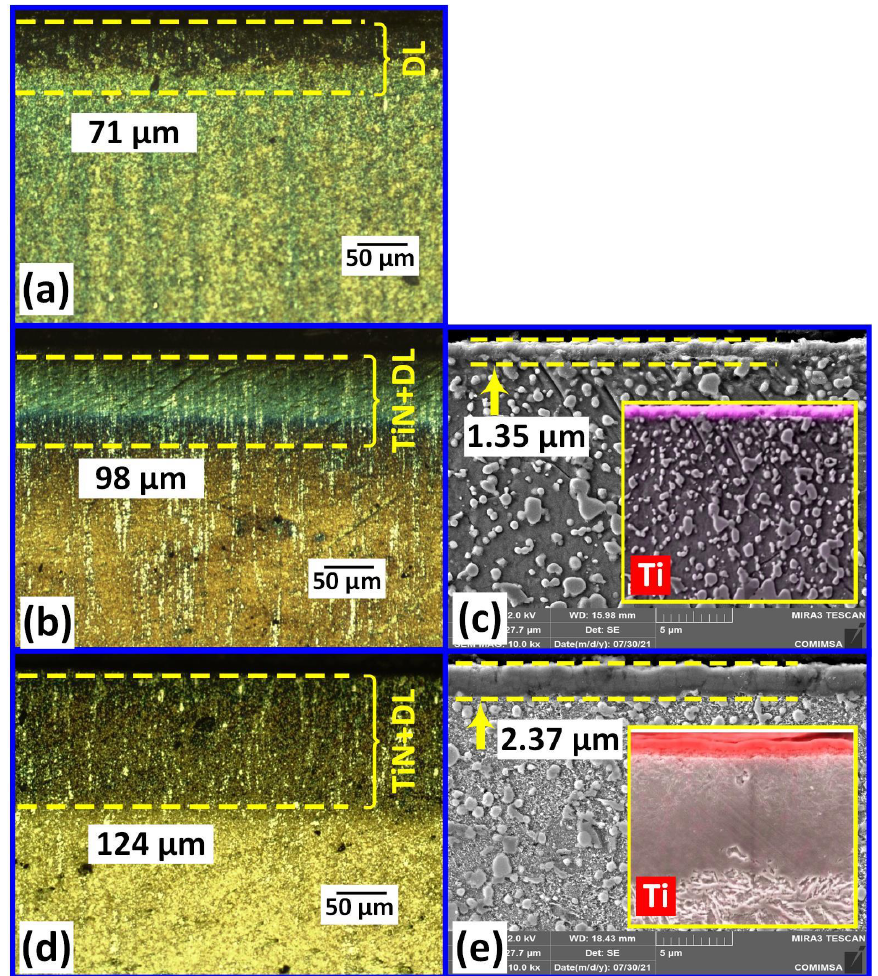
Figure 5. Cross-sectional optical micrograph of ( a ) nitrided sample, optical micrographs with SEM images of duplex-treated samples with substrate temperature for TiN deposition at ( b , c ) 400 °C and ( d , e ) 450 °C.